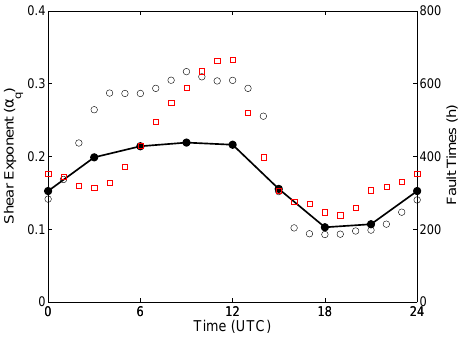
Figure 2. Diurnal variation of one-year average wind shear exponents (see Equation 1 for definition) along with turbine fault occurrences at Big Spring, TX. The observed average shear exponent values (black circles) and fault times (red squares) are reproduced from Smith et al. [13] using Engauge Digitizer 4.1. The WRF model forecast-based one-year average shear exponent values (black line with solid circles) have been calculated by the authors (see Section 3 for